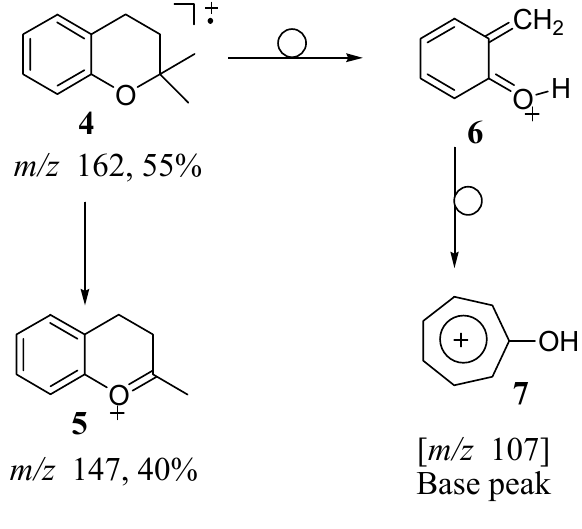
Scheme 1. EI fragmentation of 2,2-dimethylchroman 4 (intensities are indicated in